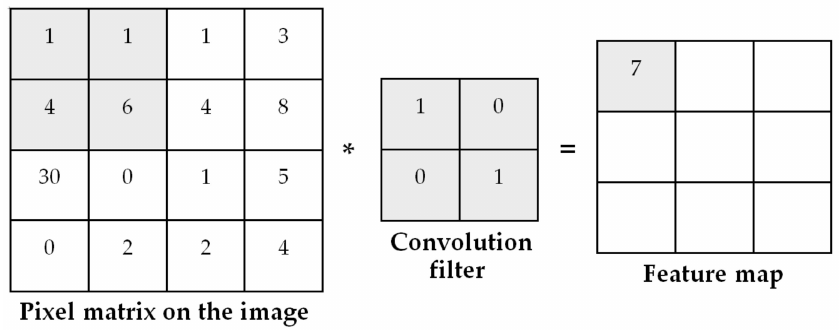
Figure 3. Feature maps generated by the convolution